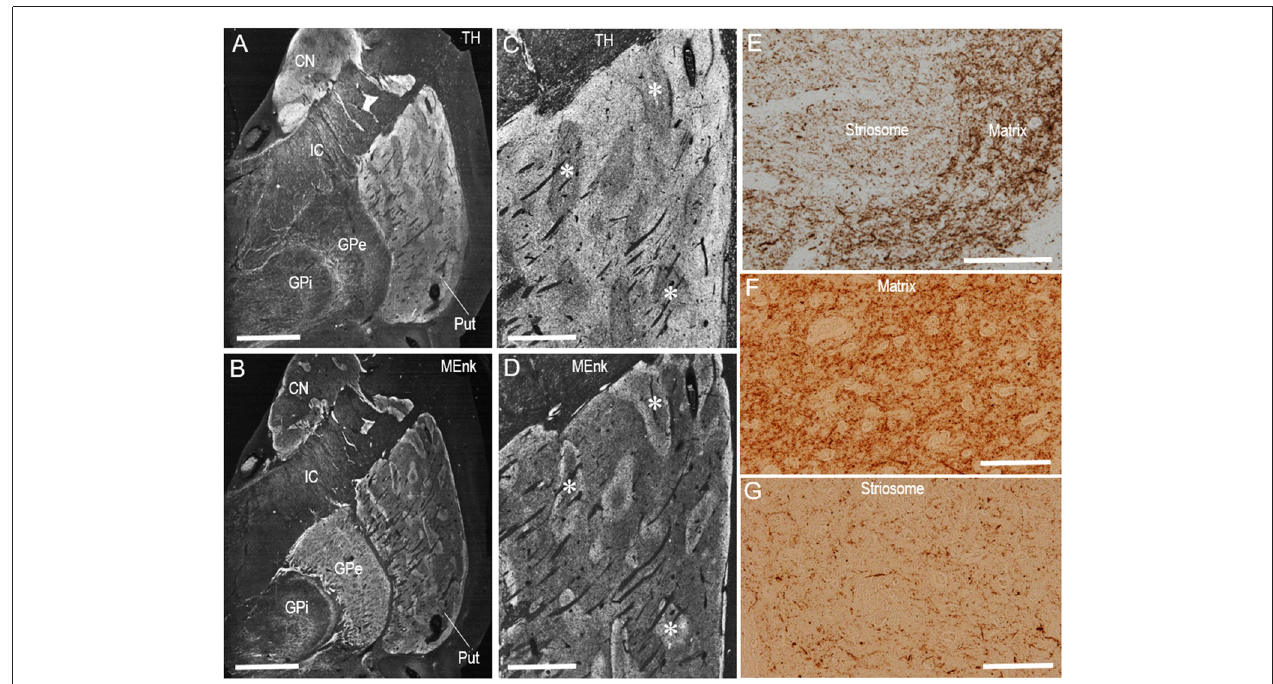
FIGURE 4 | Compartmental distribution of TH immunoreactivity in the caudal putamen of the human brains. (A–D) Serial-section analysis of dark-field images of the lenticular nucleus (A,B) and caudal putamen (C,D) stained with DAB for TH (A,C) and MEnk (B,D) . Asterisks indicate examples of corresponding striosomes. (E) Photomicrograph at the border between the striosome and matrix in a putaminal area stained with DAB for TH. (F,G) Photomicrographs of the matrix (F) and striosome (G) in the putamen stained with DAB for TH. Note that the matrix area revealed a greater density of TH-positive fibers and puncta, compared with the striosomal area. Abbreviations: CN, caudate nucleus; Put, putamen; GPe, globus pallidus externa; GPi; globus pallidus interna; IC, internal capsule. Scale bars: (A,B) 5 mm, (C,D) 2 mm, (E) 500 µ m, (F,G) 100 µ m.